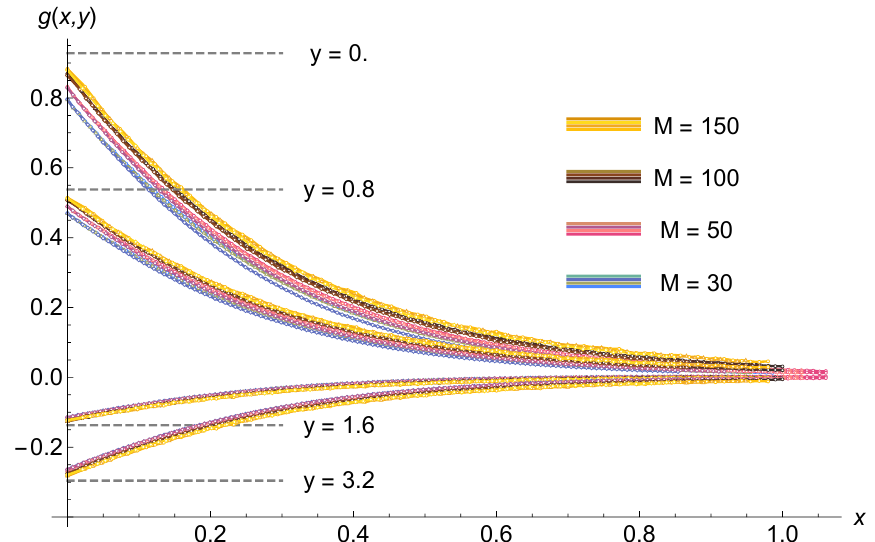
Figure 6: Numerical data and horizontal lines as in 5, except that data are shown for (cid:112) / M = 0,1 / 2,1 and one width for each M and y ; the energy windows based at E 0 energy window width is equal to the second in the list of (cid:34) values shown in figure 5 for the corresponding M and y